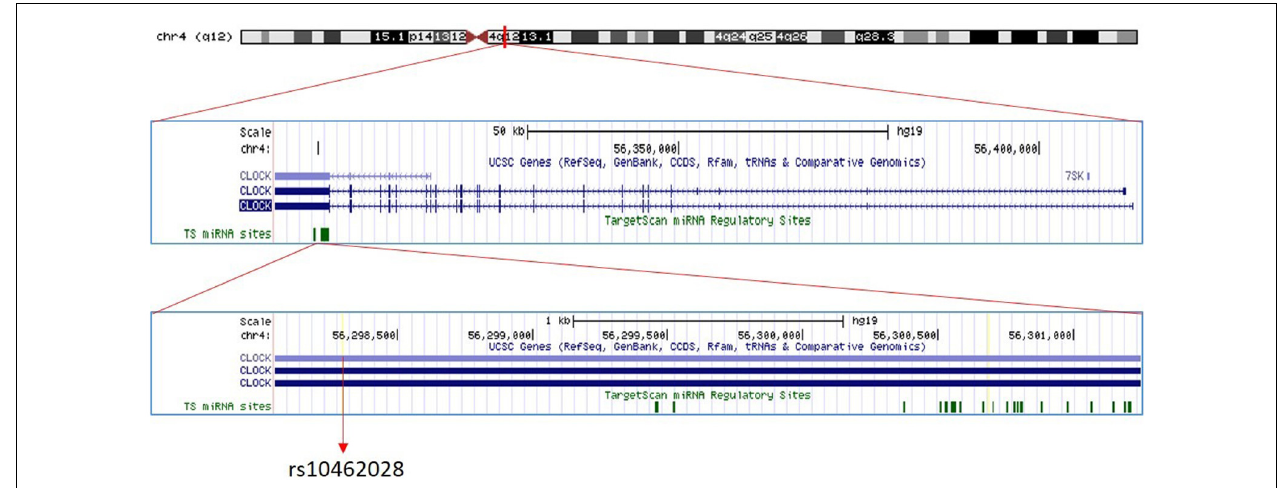
and ad.323-61/2005-1018 EKU;